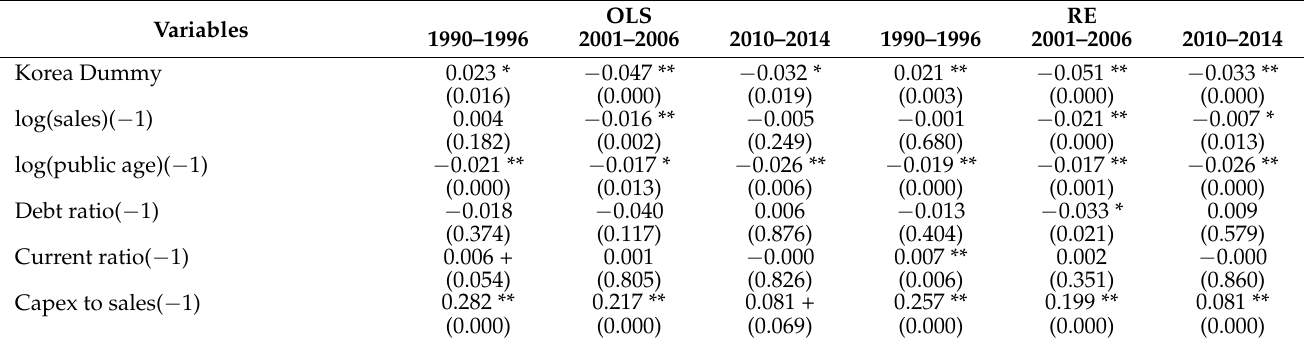
Figure 3. Comparison of sales growth rate. Table 4. Comparison of sales growth rate by regression.